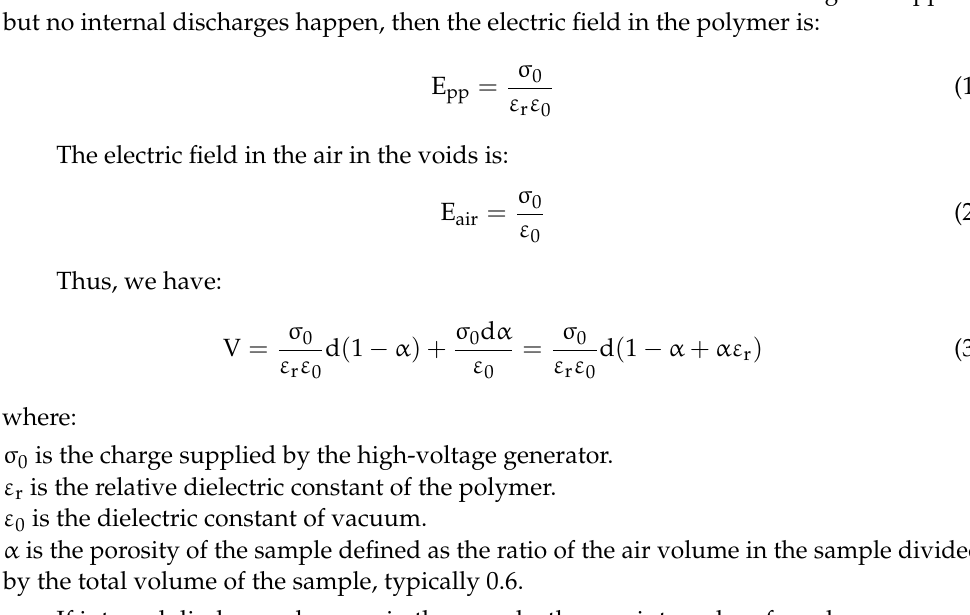
Figure 2. One-dimensional model of the sample charged with a surface charge σ 0